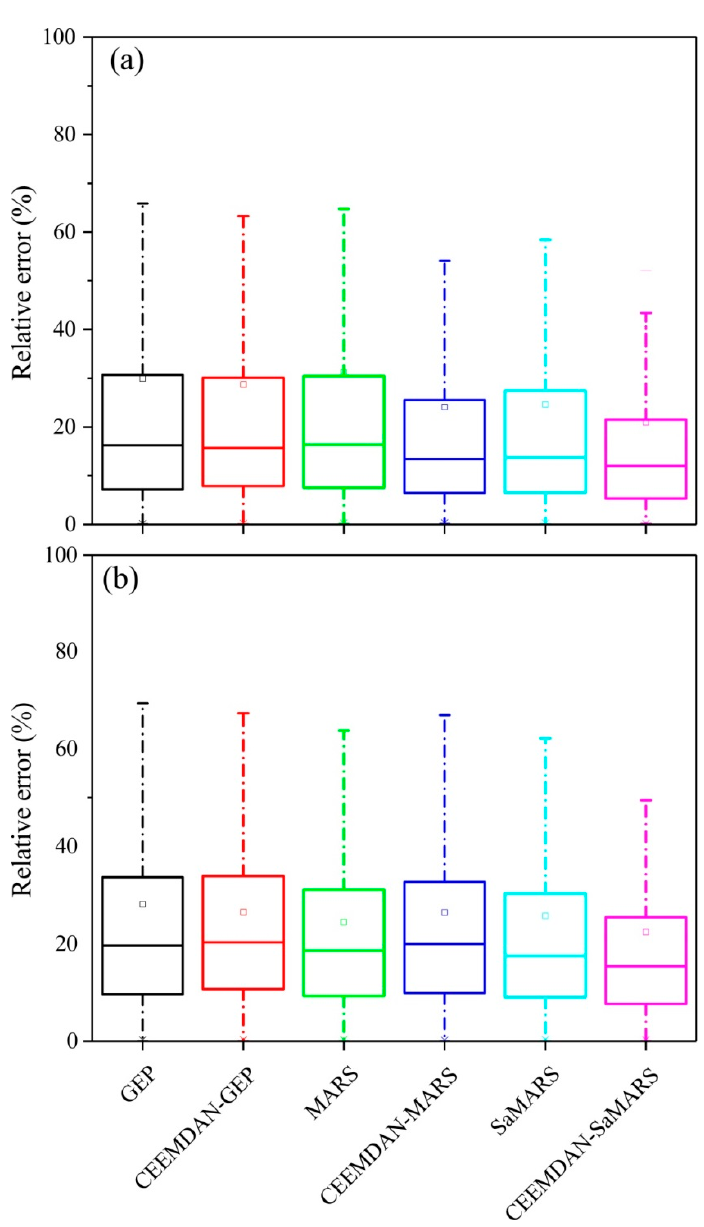
Figure 10. Box-plots of relative error of forecasted values of DSR (MJ /m 2 ) using the standalone and hybrid models at ( a ) Busan ( b ) Incheon stations in the validation phase.